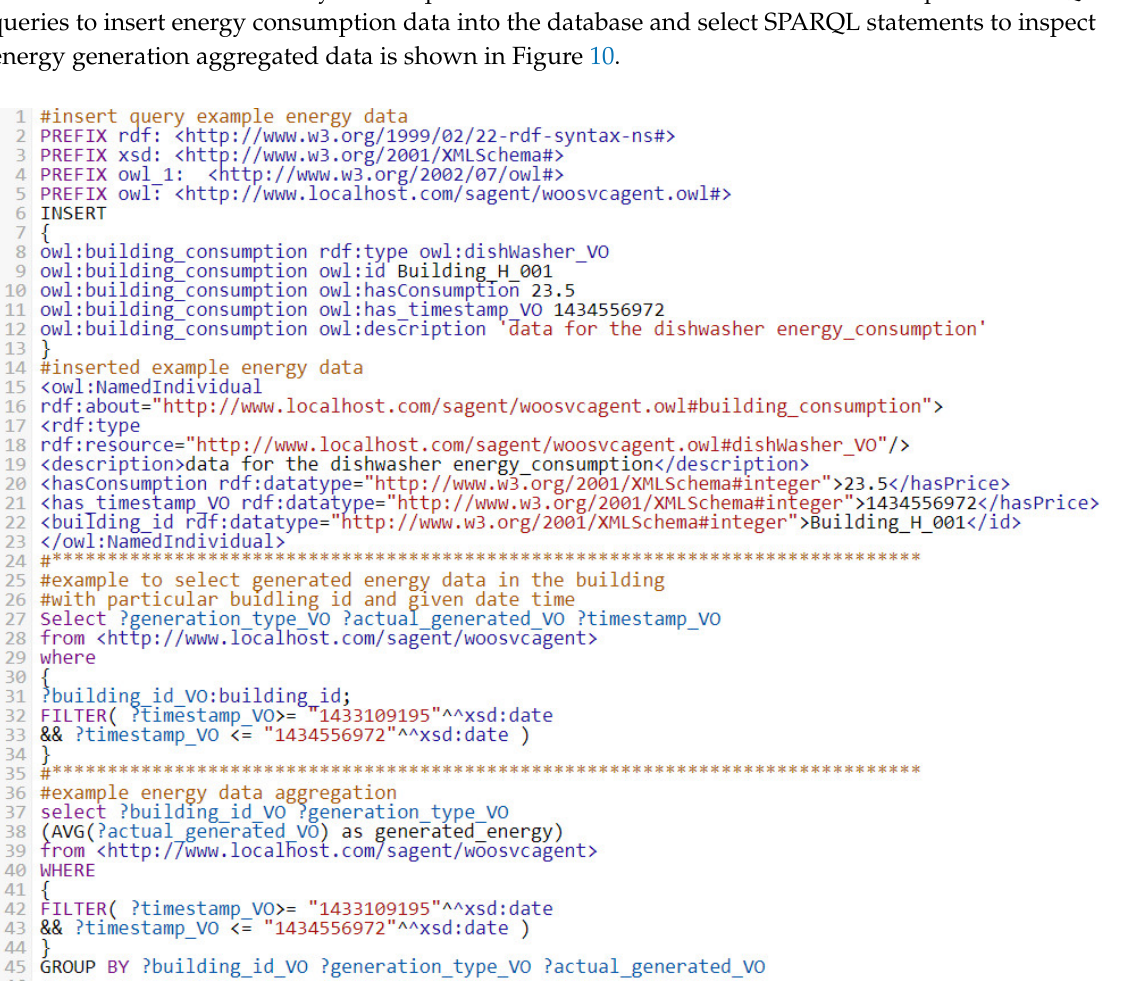
Figure 10. Excerpt examples of SPARQL queries used in the experimentation.